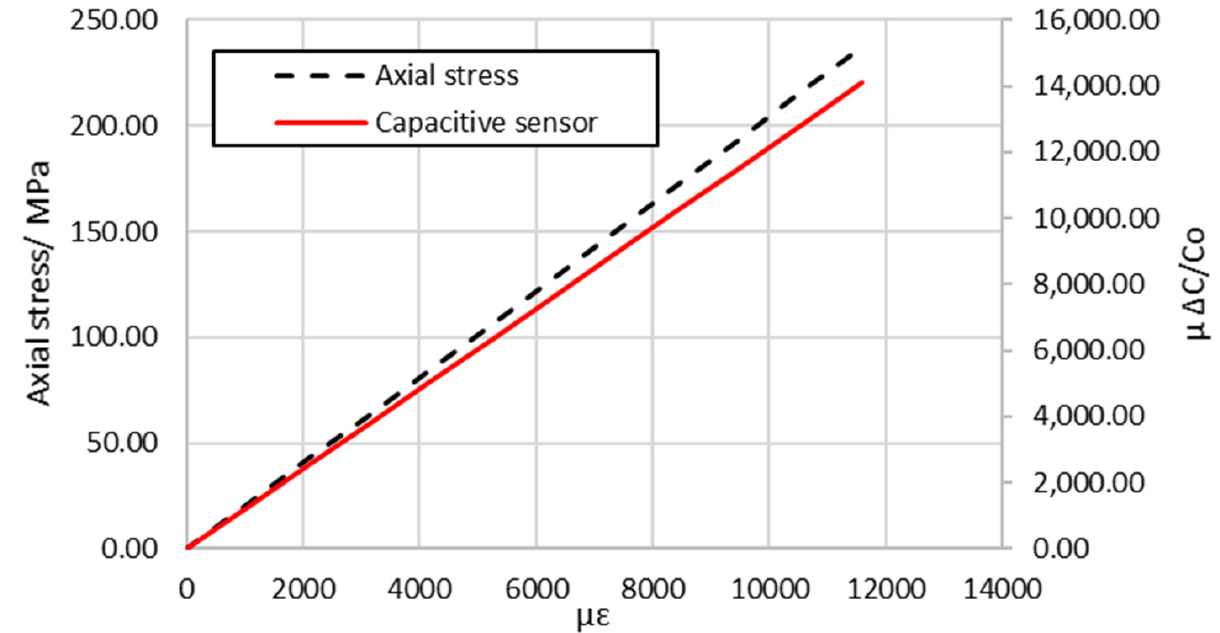
Figure 12. Simulated axial stress and the relative change in capacitance against the nominal strain using FEM to obtain the effective elastic modulus (Ex) and gauge factor for the capacitive sensor. Table 7. Comparison of the measured and the finite element predicted effective elastic modulus and gauge factor.